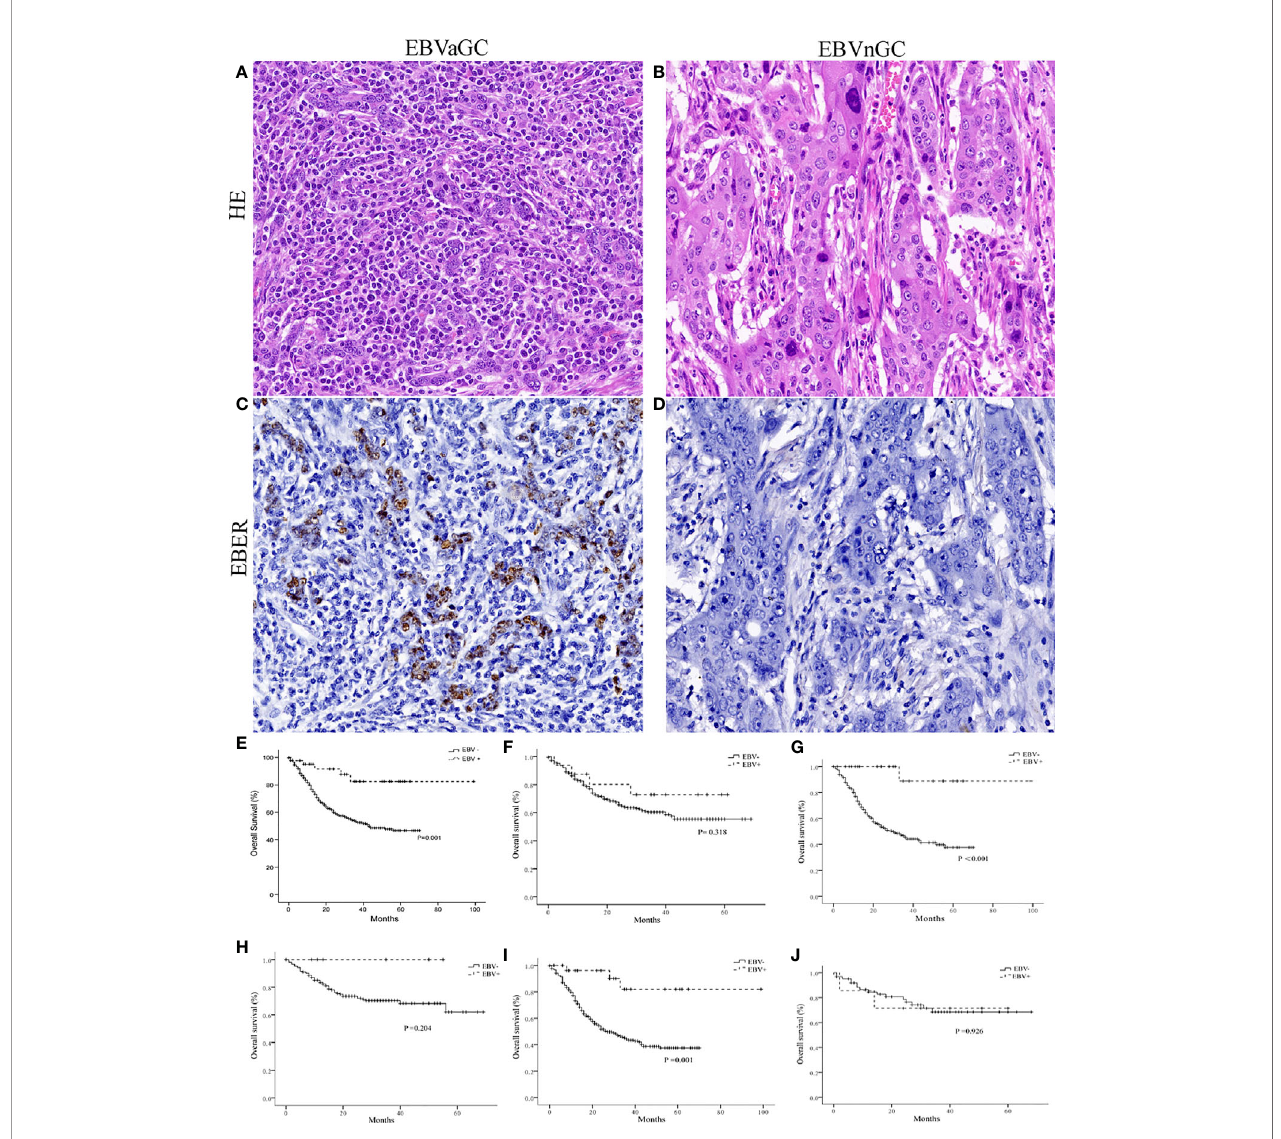
FIGURE 1 | Histology, EBER-1 ISH, and survival curves in EBVaGC and EBVnGC. Histology of the representative cases of EBVaGC (A) and EBVnGC (B) (×400). EBER-1 ISH revealed strong nuclear staining in EBVaGC (C) , but not in EBVnGC (D) (×400). (E) Kaplan-Meier survival curves for overall survival in 42 cases of EBVaGC and 804 cases of EBVnGC. EBVaGC had better prognosis than EBVnGC (P = 0.001, Log-rank test). When patients were strati fi ed based on tumor size [<5 cm (F) ; >5 cm (G) ] and Lauren classi fi cation [Intestinal (H) , Diffuse (I) , Mixed (J) ], EBVaGC exhibited longer overall survival than EBVnGC in patients with tumor size >5 cm (P < 0.001) and Lauren diffuse type (P =